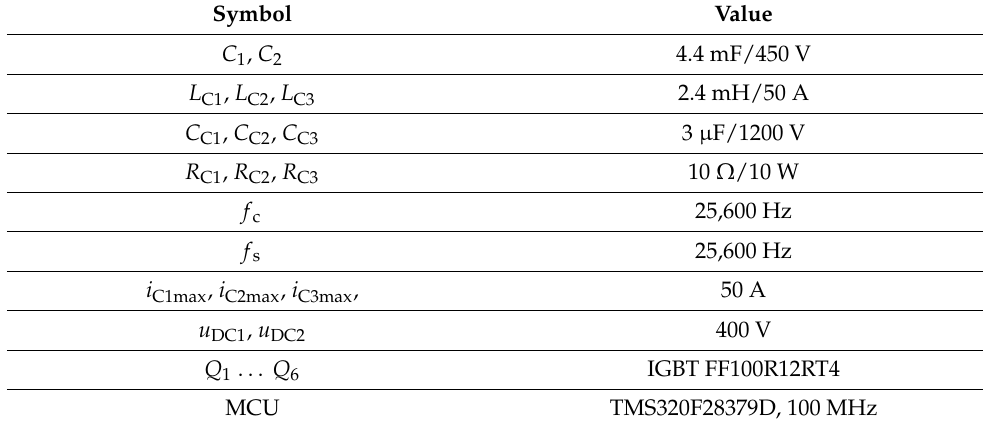
Table 1. Main parameters of the APF